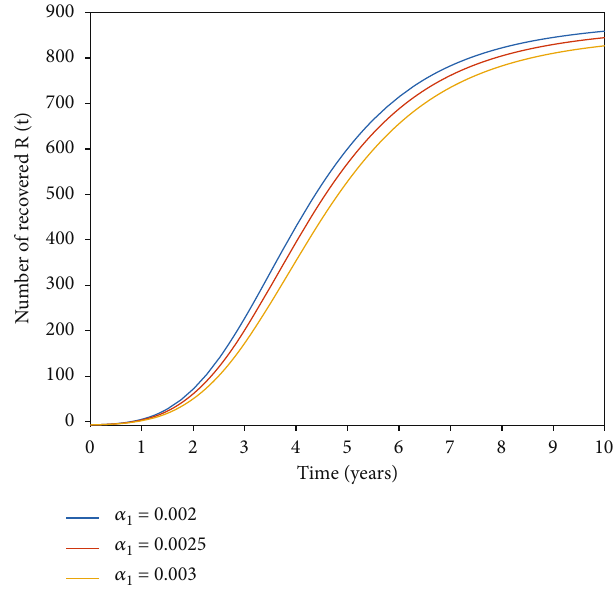
Figure 14: Transformation of susceptible individuals for varied infection rate α 1 .